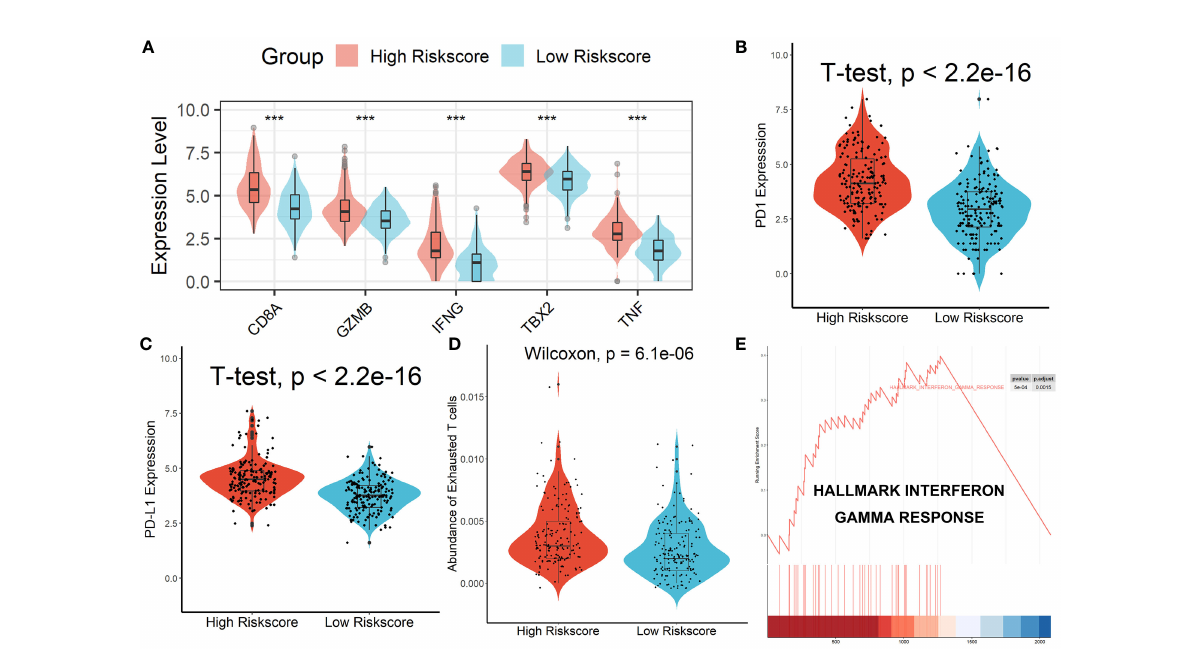
FIGURE 8 Patients in the high-risk score group had an Exhausted Immune Microenvironment. (A) Differential analysis of in fl ammation/immune response- related genes. (B, C) Differential analysis of PD1 and PD-L1 expression. (D) Exhausted T cells were signi fi cantly enriched in the high-risk scores group. (E) The low-risk scores group displayed an attenuated IFN- g response. ***p <